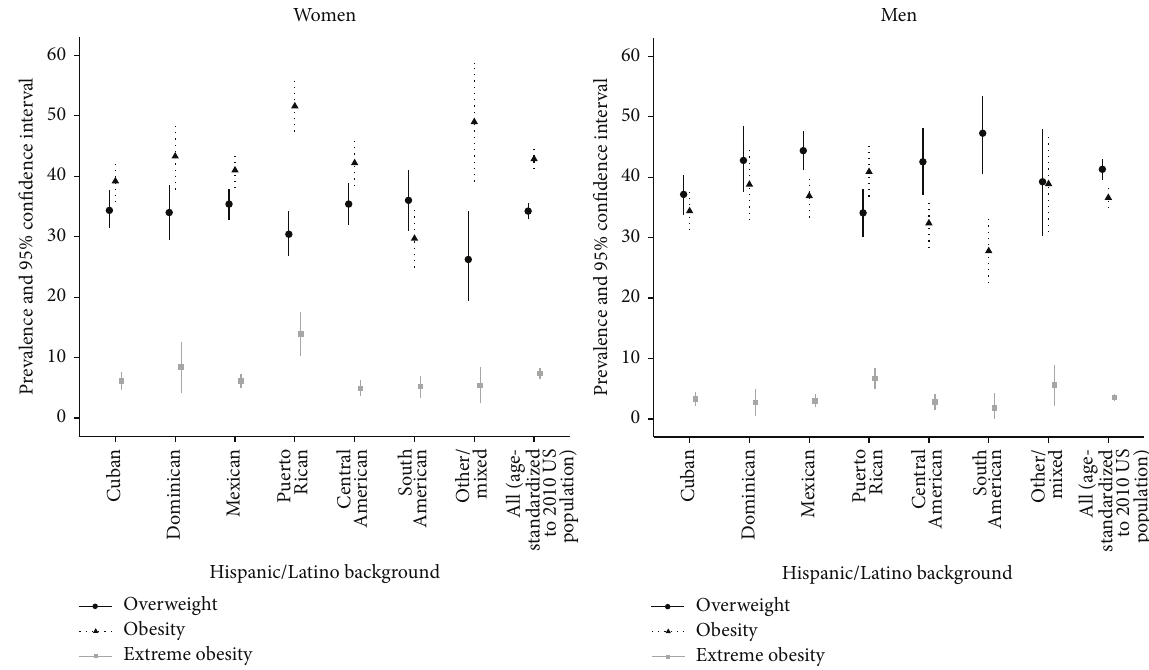
Figure 1: Age adjusted prevalence of overweight (BMI = 25–29 kg/m 2 ), obesity (BMI ≥ 30 kg/m 2 ), and extreme obesity (BMI ≥ 40kg/m 2 ) by sex and Hispanic/Latino